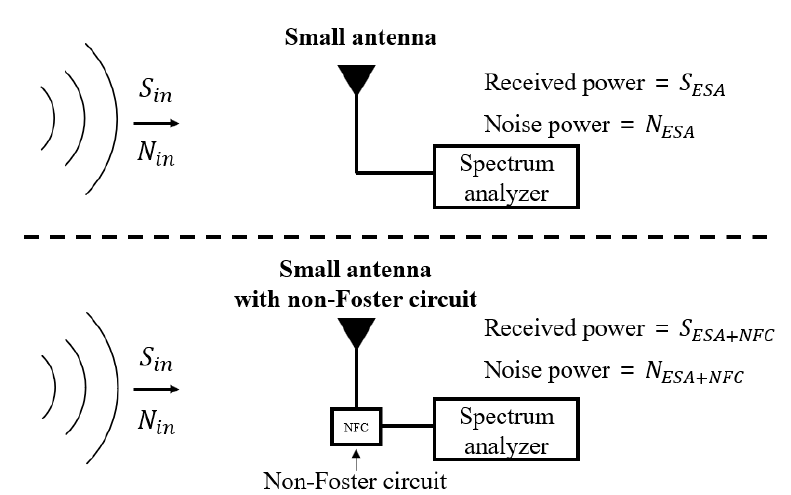
Figure9. Themeasurementsetup forsignal-to-noise ratiomeasurementwithoutand withthenon-Foster Figure 9. The measurement setup for signal-to-noise ratio measurement without and with the circuit non-Foster circuit connected.